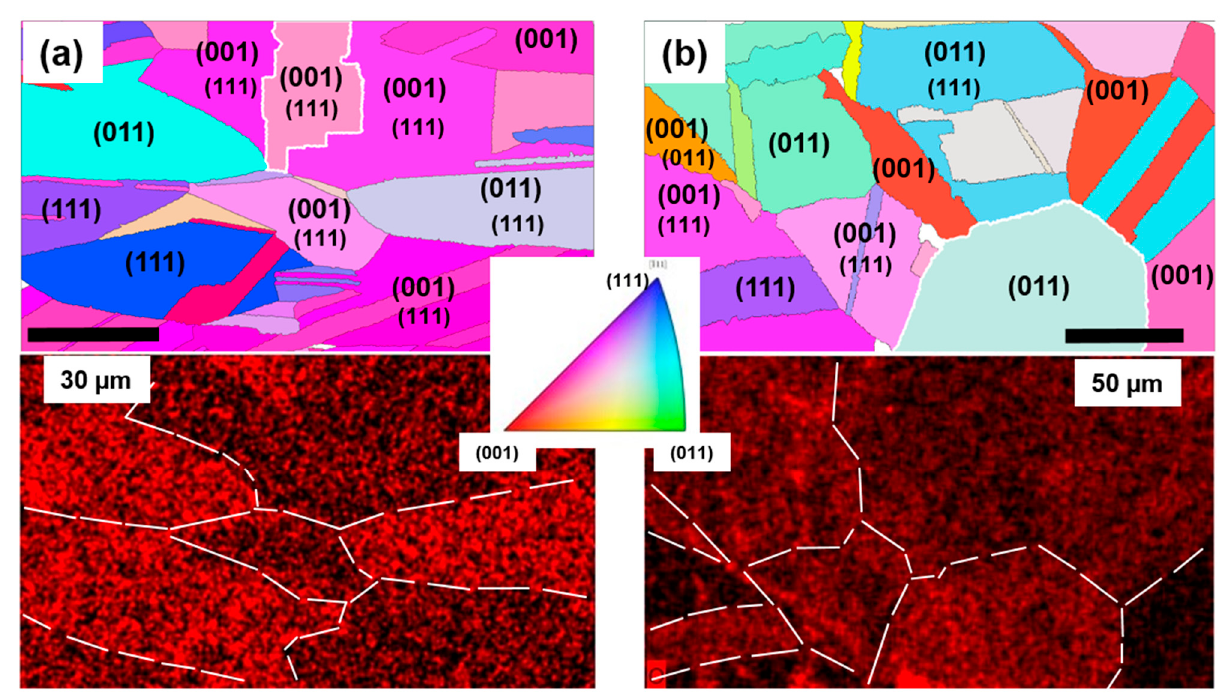
Figure 6. ( a ) EBSD orientation map of the investigated spot on the “fresh” sample ( top ) with corresponding EDX oxygen elemental distribution map ( bottom ). ( b ) Same as ( a ) for sample “6 months”. In the top panels, for grains with incomplete low-index orientation, the minor component is indicated in smaller font below the dominant one. Bottom panels: some Cu grains are delineated by a dashed line for clarity; the intensity of the red coloring corresponds to the oxygen concentration. Inset: orientation color code.